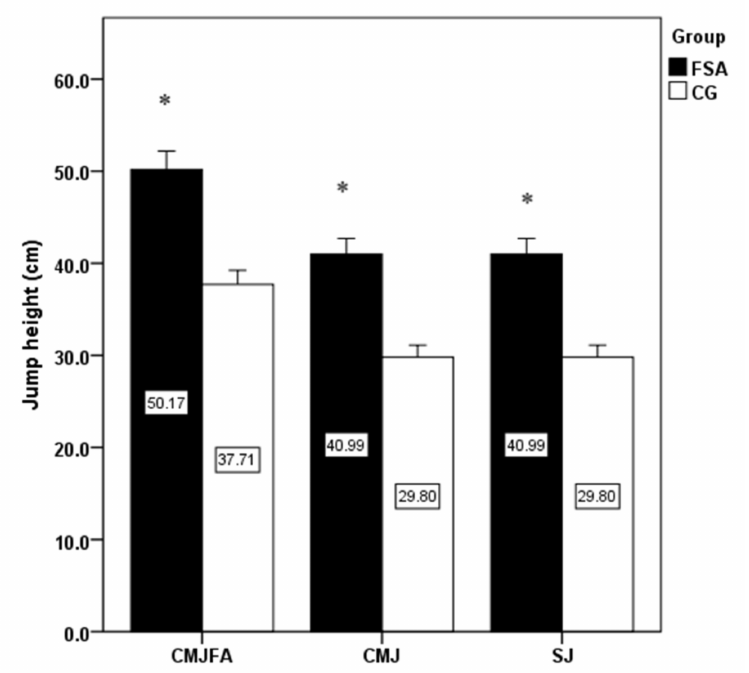
Figure 1. Comparison of jump height differences between groups. Note: CMJFA: countermovement jump with free arms; CMJ: countermovement jump; SJ: squat jump; FSA: fire sports athletes; CG: control group; *: significant difference between